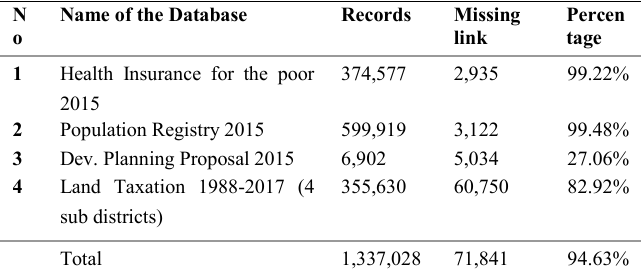
Table 4: Percentage of linkable records to RT as geolocation identifier